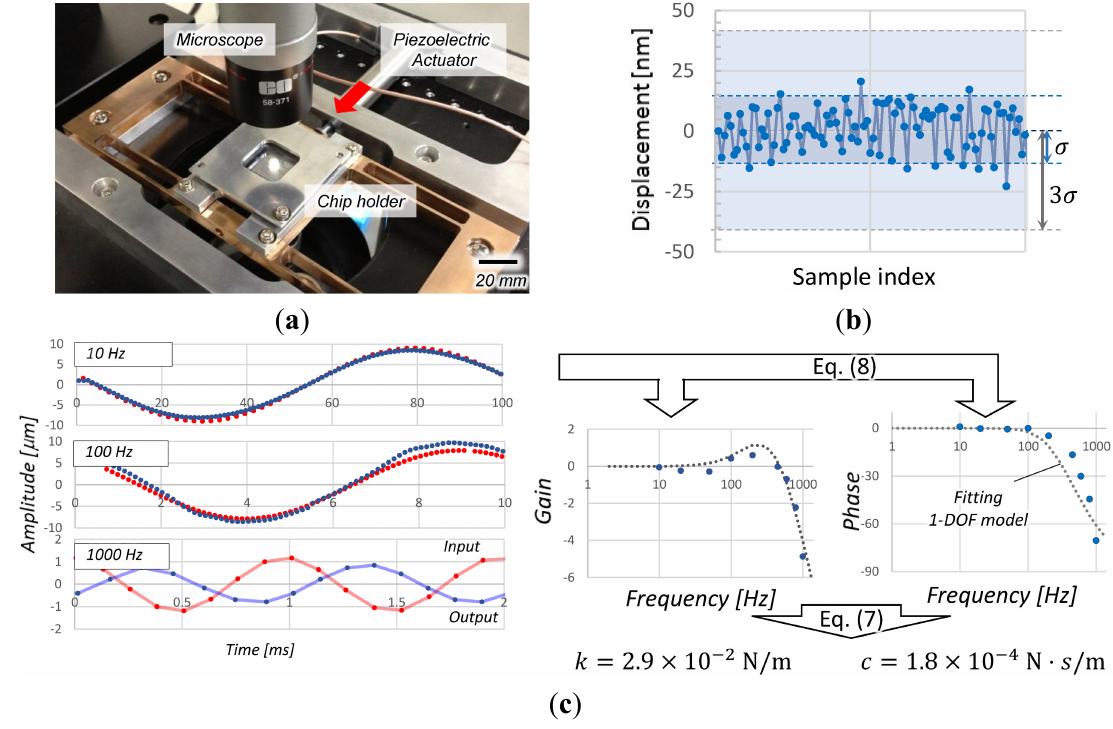
Figure 6. Confirmation of experimental performance: ( a ) image of the system setup; ( b ) precision of the proposed sensing method; and ( c ) typical examples of the data used for the calibration